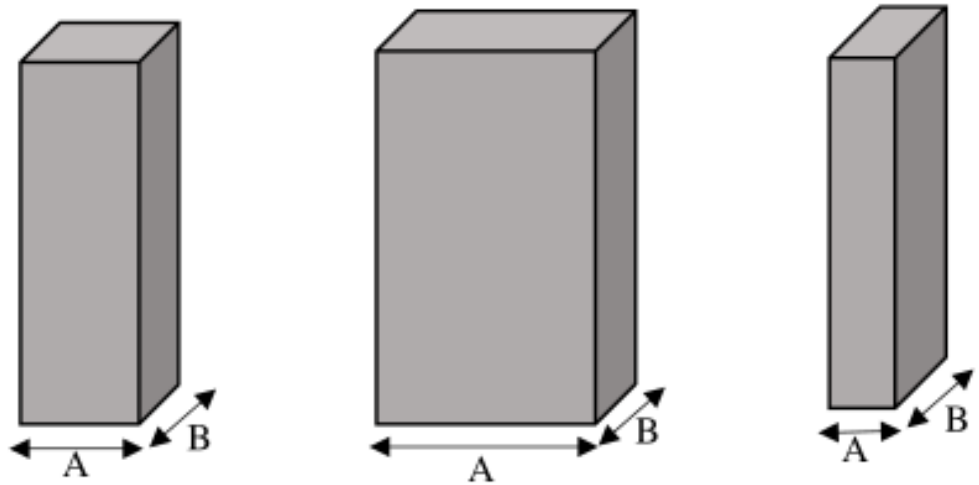
Figure 5. 3D view of the rectangular piles for CFD simulations with different aspect ratios (B:A) of 1:1 ( left ), 1:2 ( middle ), and 2:1 ( right ). B is the length of rectangular piles and A is the width of the